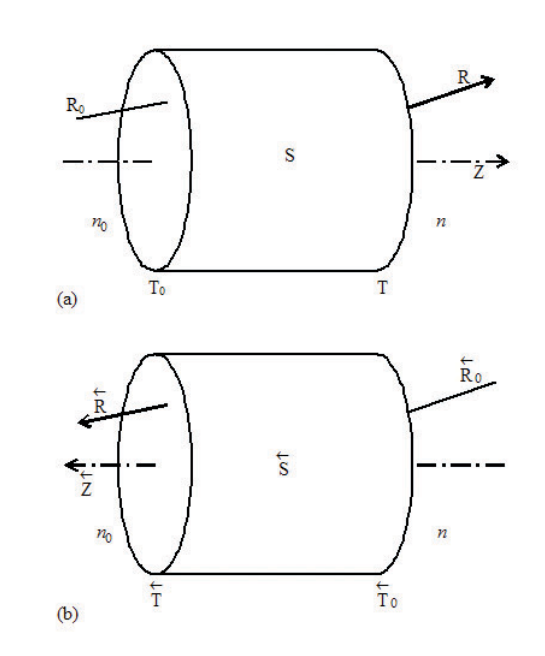
Figure 1 An arbitrary optical system S in (a) has longitudi- nal axis Z and entrance and exit planes T and T respectively. 0 When applied to the eye T may be immediately in front of the 0 cornea and T immediately in front of the retina. The medium immediately before the system has index n and the medium 0 immediately after it has index n . An arbitrary ray R 0 R traverses ← ← the system. The ray is reversed in (b) to become ray R R 0 The system becomes the reversed system S with longitudinal axis